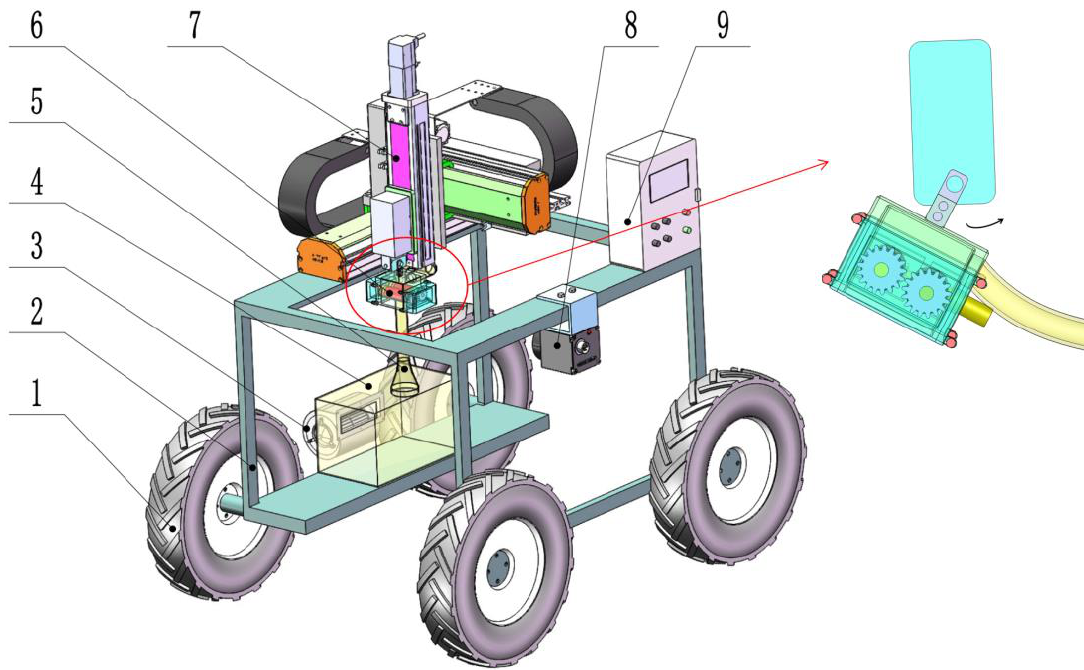
Figure 1. The overall structure of safflower picking robot. 1 . Walking device; 2 . Machine frame; 3 . Fan; 4 . Collecting box; 5 . Collecting hose; 6 . Dual rollers type end-effector; 7 . Three-axis linear manipulator; 8 .Visual recognition system; 9 .Control box.